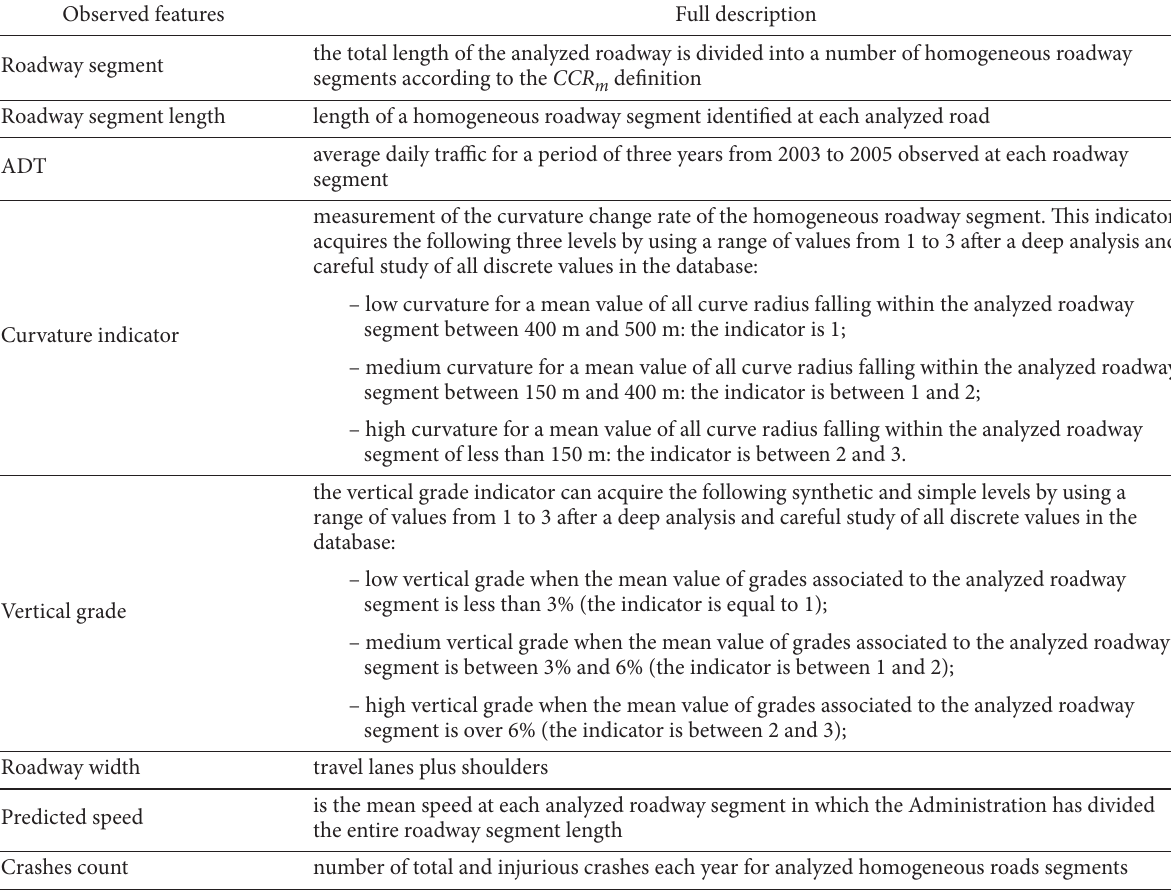
Table 2. Parameters of the analyzed roadway segments Observed features